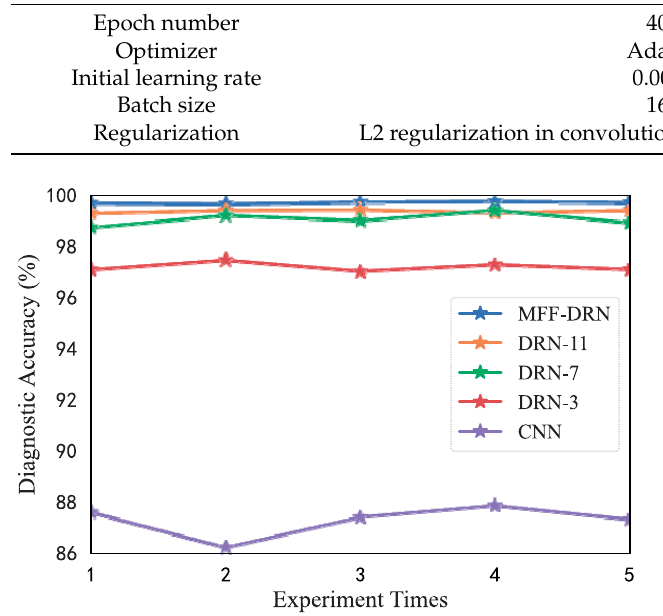
Figure 7. Diagnostic accuracy comparison of five methods in Case 1. Table 4. Experimental results in Case 1 (%).